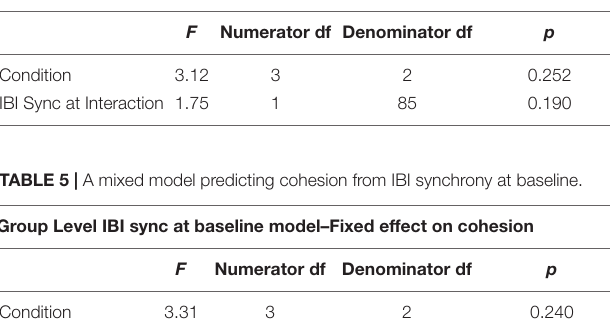
TABLE 4 | A mixed model predicting cohesion from IBI synchrony at the interaction. Group Level IBI sync at interaction model–Fixed effect on cohesion